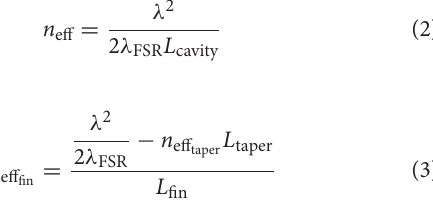
lines underneath the suspended left-side fins are the edges of pyramidal semi-stable planes which have not been fully